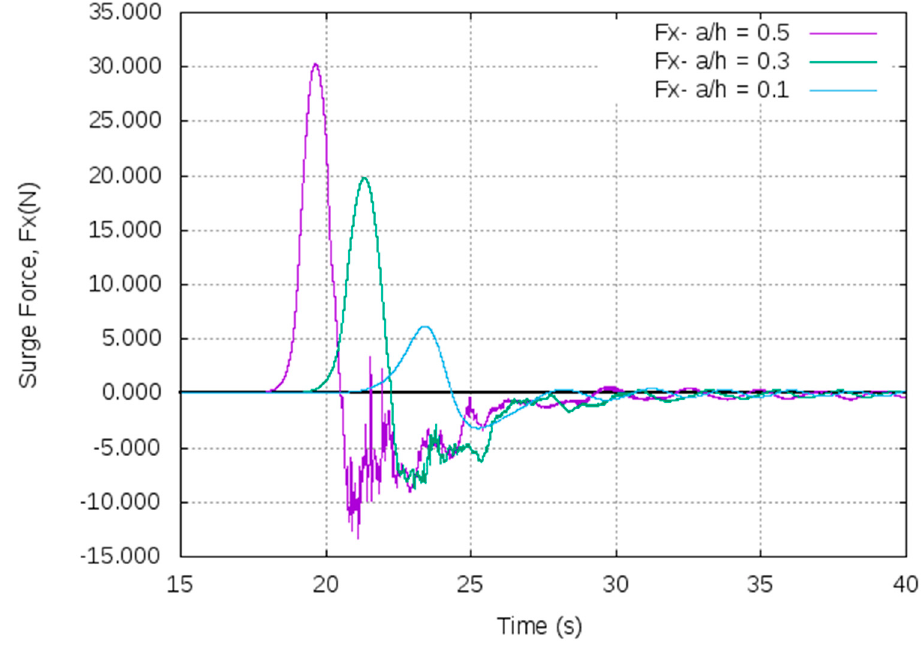
Figure 9. Surge or longitudinal force experienced by the pontoon while encountering solitary wave (for 0.1, 0.3, and 0.5 a h = ).